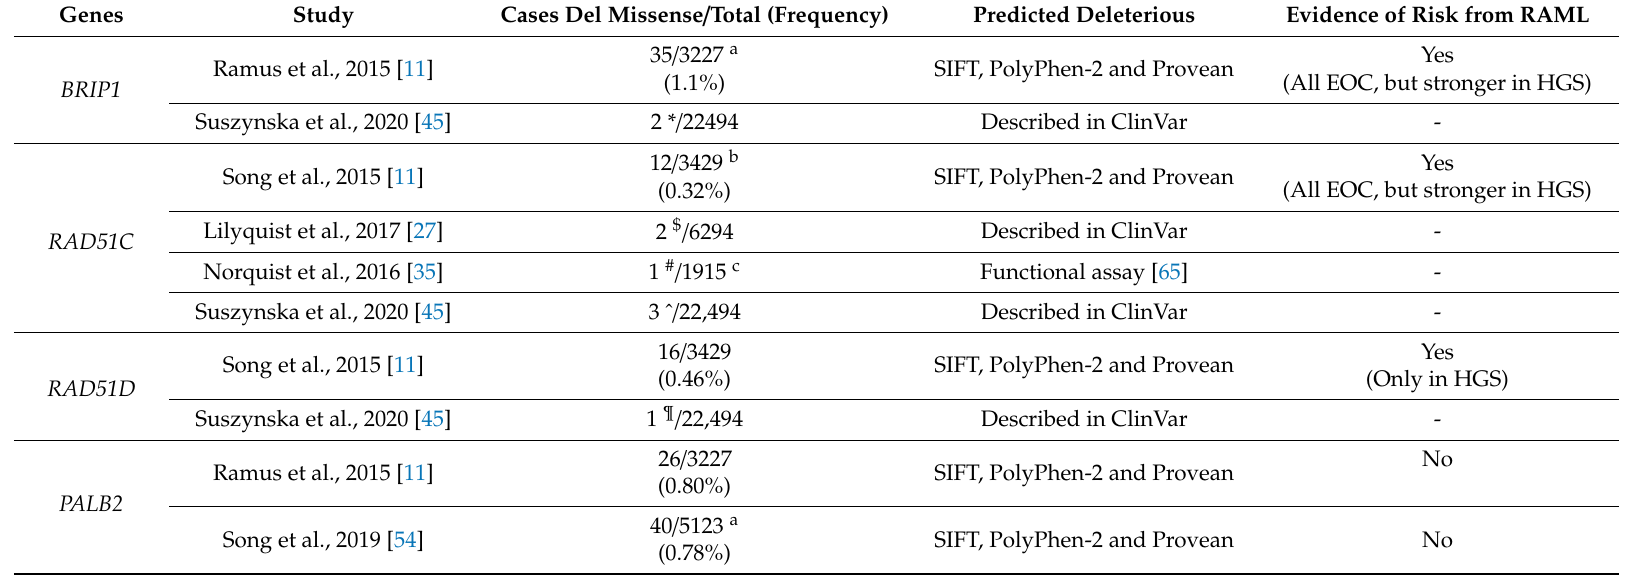
Table 5. Predicted deleterious missense variants in known moderate risk genes for